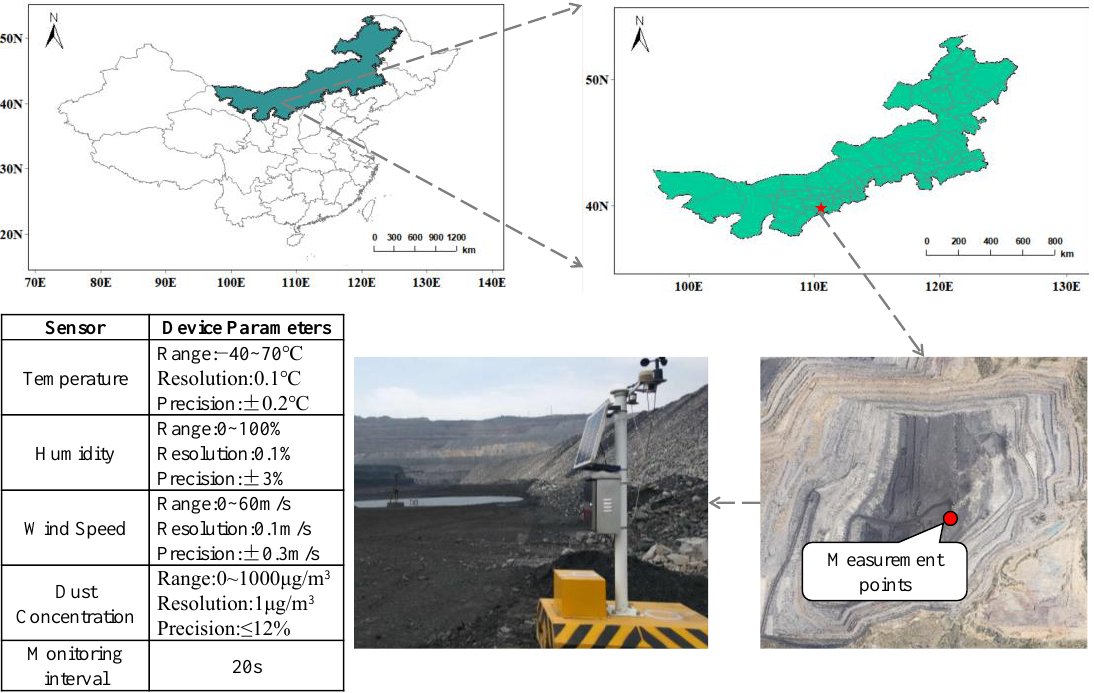
Figure 1. Mining area and measuring point location.